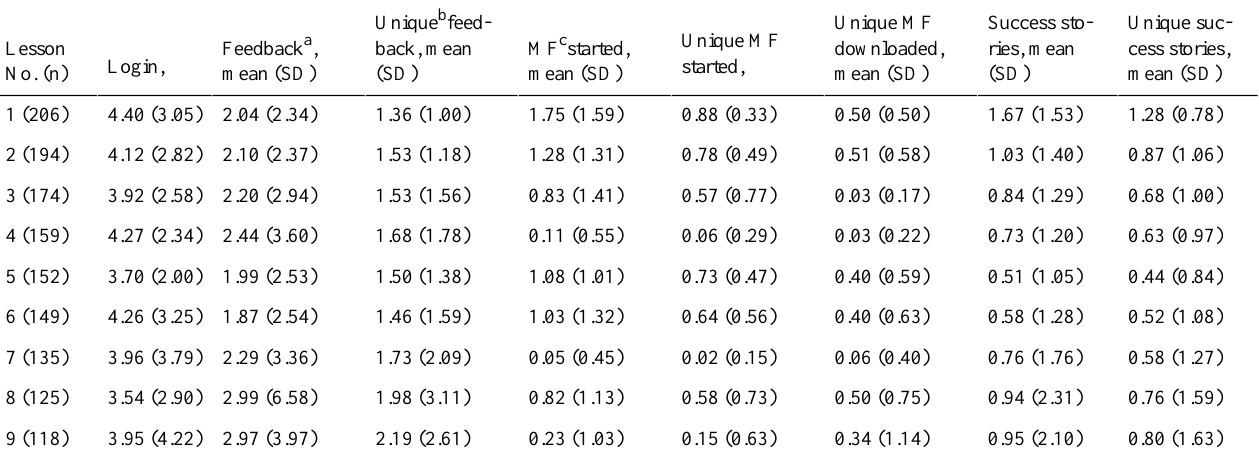
Table 1. Mean logins and mean use of features available for all participants per